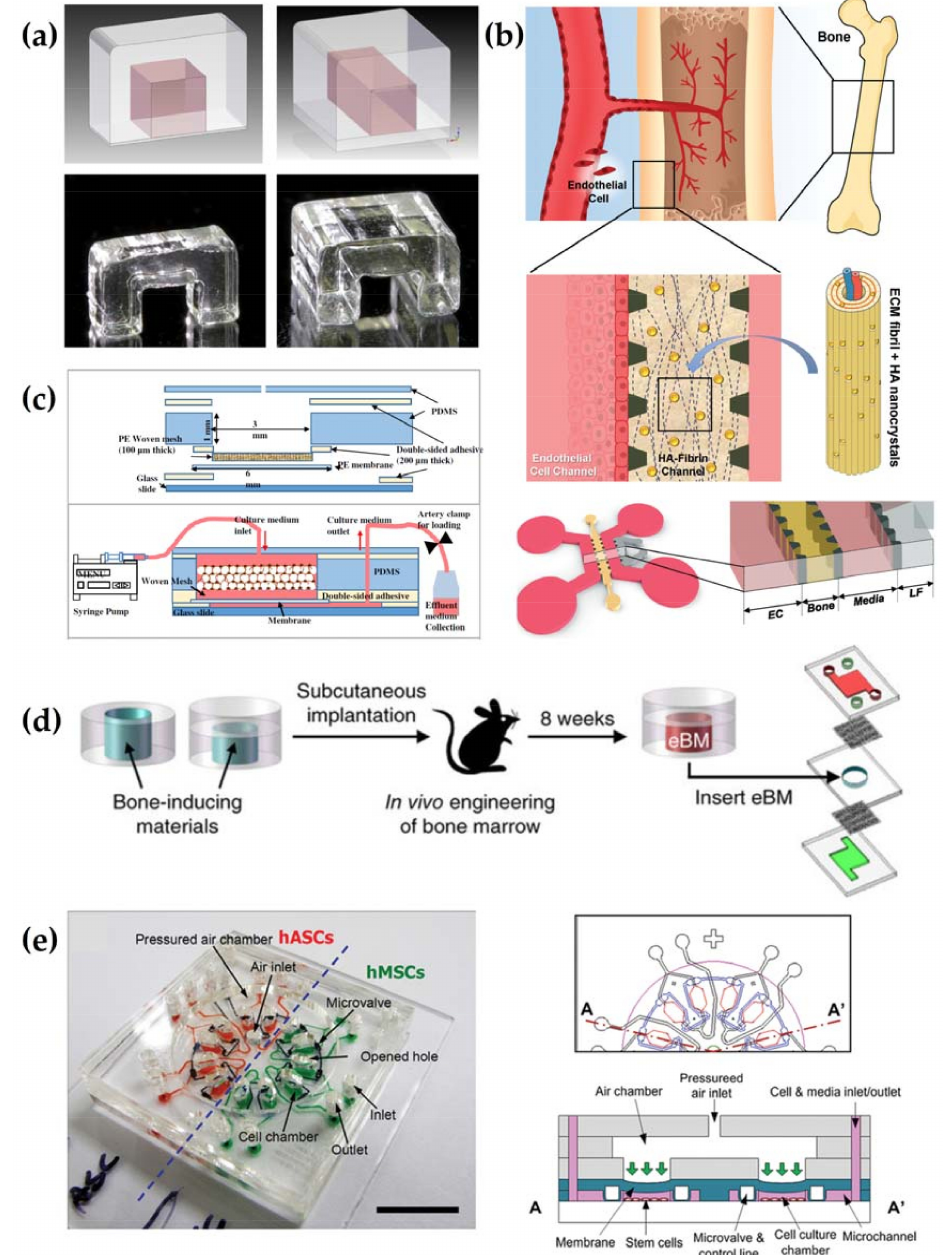
Figure 2. Different microfluidic systems for modeling a respective physiologic aspect of bone. ( a ) A polymethylmethacrylate (PMMA) cage was employed as a mould for a hydrogel-based model to investigate the effect of different oxygen levels on vascularization. Reprinted from [206] with permission